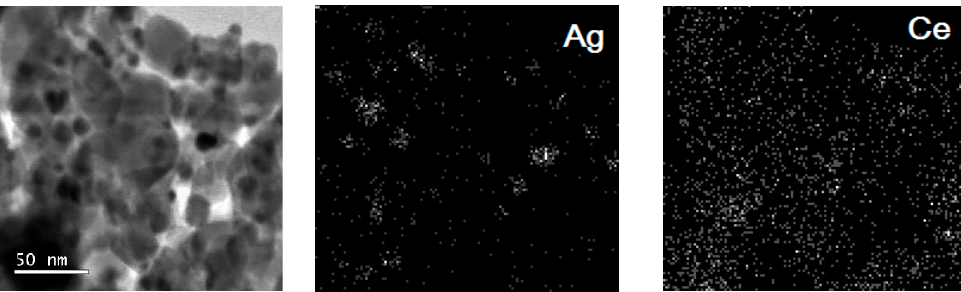
Figure 4. Low-magnification HRTEM micrograph and corresponding elemental maps in false colors for Ag and Ce extracted from the EDS data cube for Ag/Ce/TiO 2 sample treated in H 2 flow at 300 °C for 1 h.